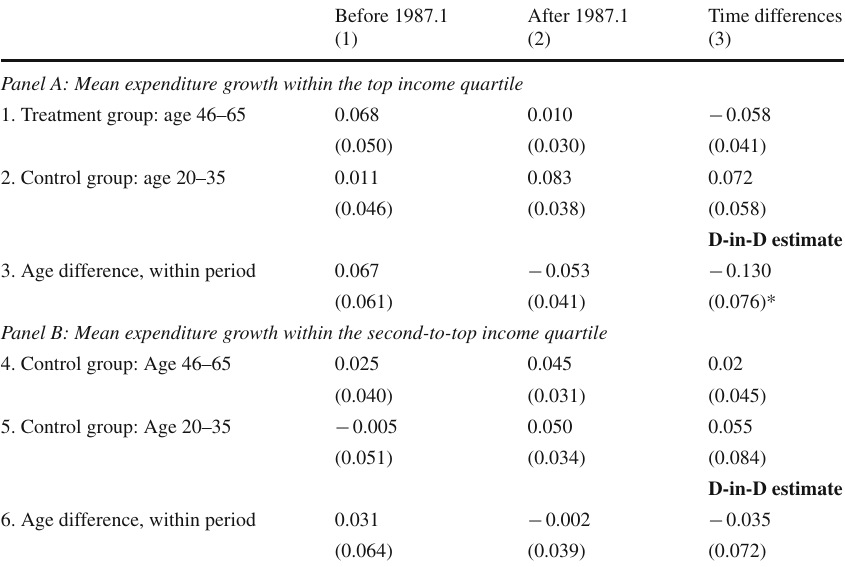
Table 11 Average four-quarter log expenditure growth for selected groups, by age and time period Before 1987.1 After 1987.1 Time differences